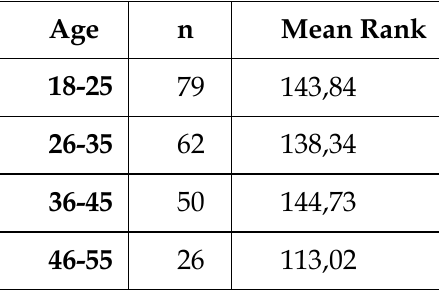
Table 25. Willingness to use the Digital Health Centre and age. Kruskal-Wallis mean